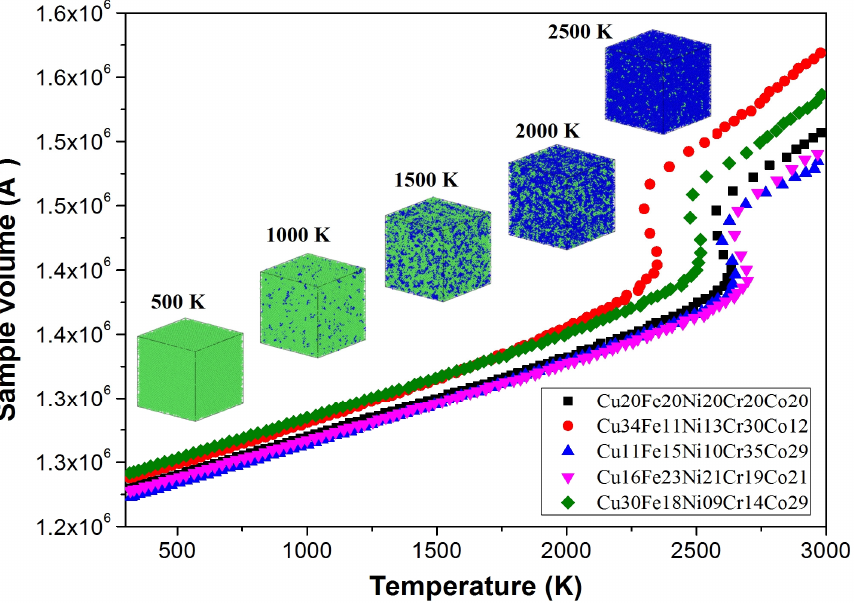
Figure 2. The HEA sample volume as a function of temperature from 300 K to 3000 K. The inserted snapshots show the atomic configurations of the Cu 30 Fe 18 Ni 9 Cr 14 Co 29 sample at different tempera- ture levels. Atoms are coloured by CNA method; the green atoms represent the face-centered cubic structure, and the blue atoms are in disorder.